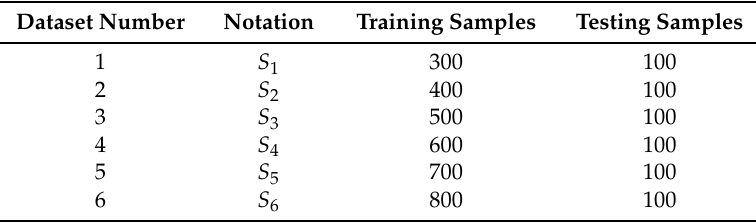
Table 2. The selected six datasets.